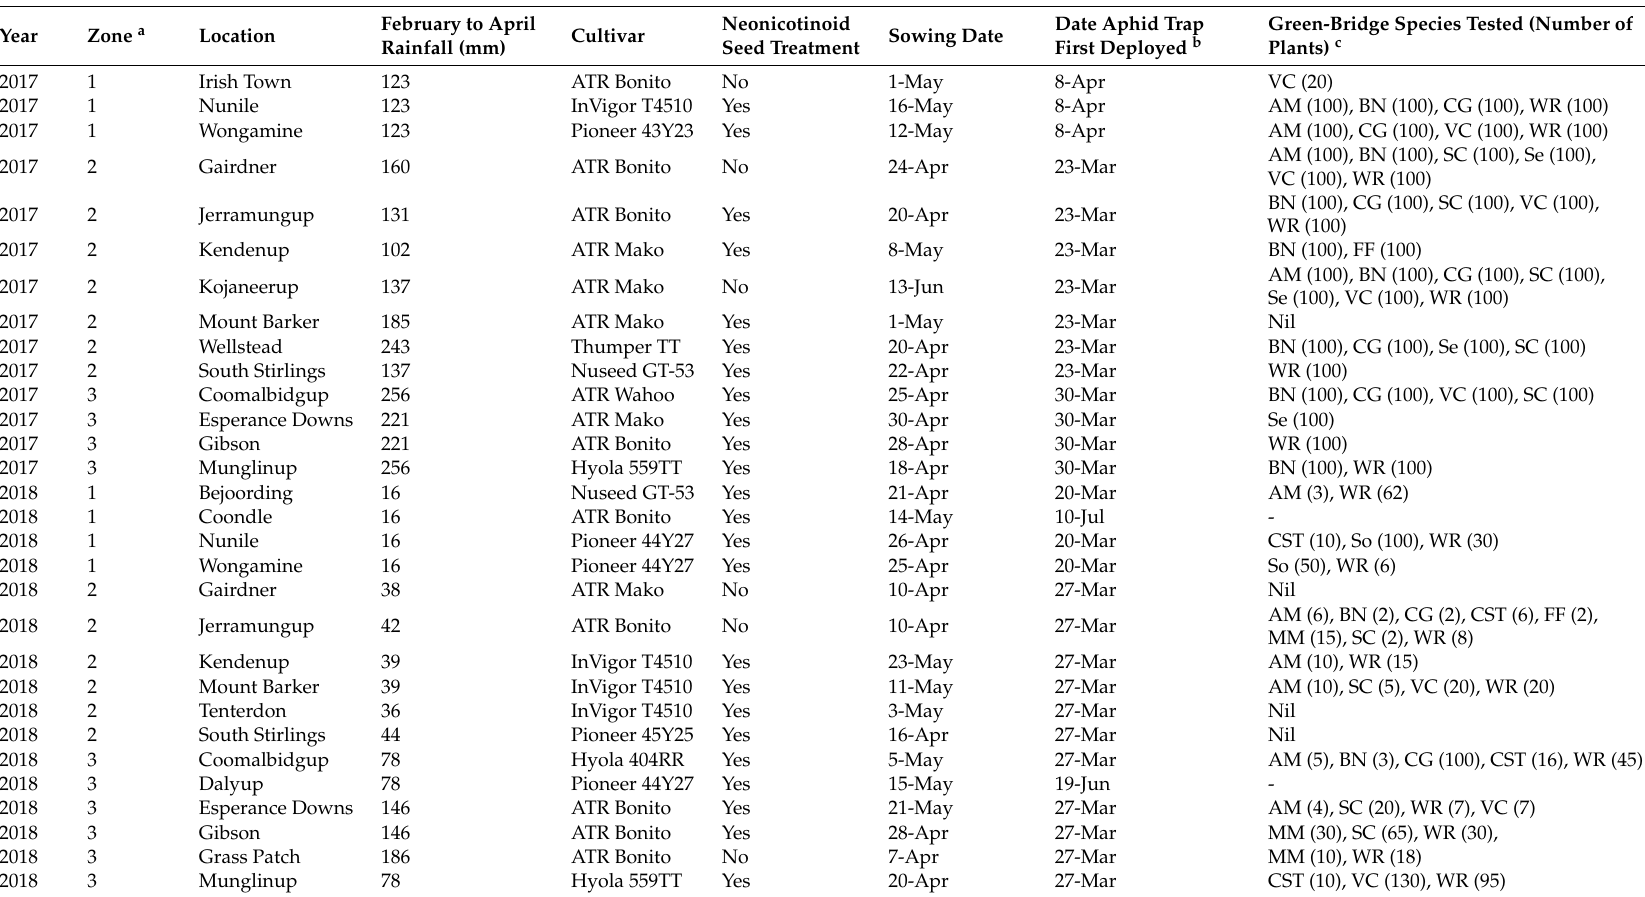
Canola ( Brassica napus ) growing site details for field validation of Turnip yellows virus (TuYV) reverse-transcription loop-mediated isothermal amplification